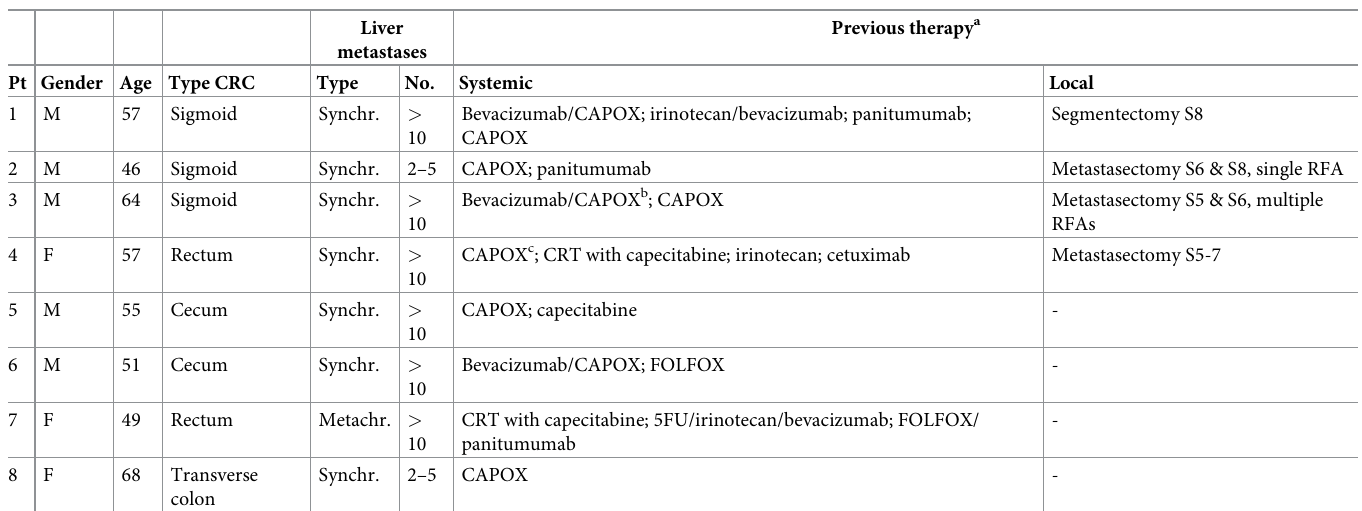
Table 2. Baseline characteristics.